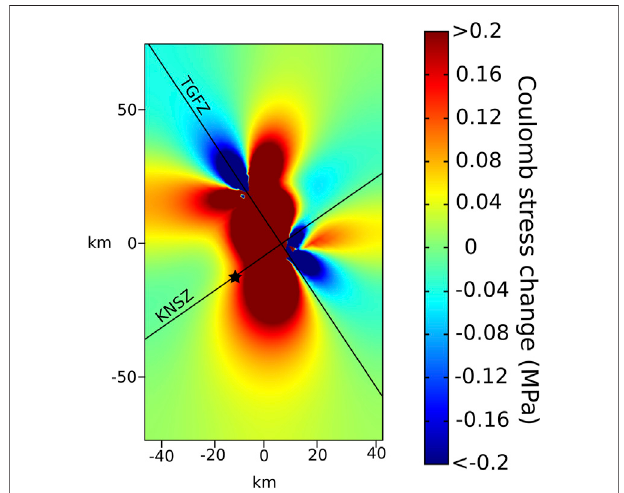
FIGURE 8 | Modeled present-day accumulation of Coulomb failure stress change on vertical faults parallel to the Karaman-Ni ğ de shear zone (KNSZ) at a depth of 8 km due to right-lateral gradual slip of 0.58 mm yr − 1 along the TGFZ. The black star marks the epicentral location (from the USGS earthquake catalogue) of the 20th of September 2020 M5.1 earthquake. The earthquake occurred in an volume of predicted positive Coulomb failure stress change where the shear zone would have undergone unclamping, thus encouraging rupture.